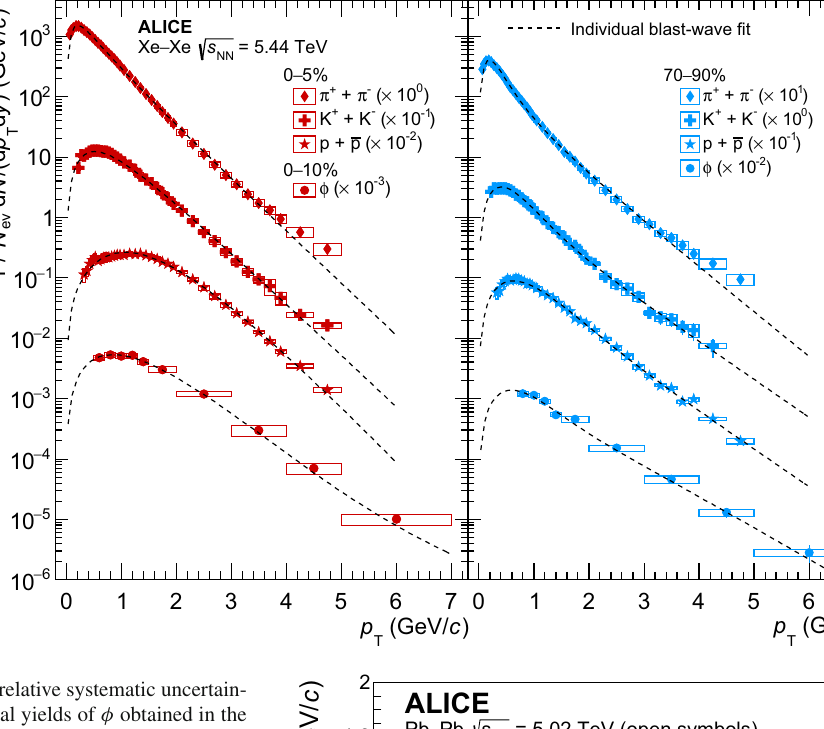
Table 3 Main sources and values of the relative systematic uncertain- ties (expressed in %) of the p T -differential yields of φ obtained in the analysis of Xe–Xe collisions. When two values are reported, they cor- respond to the lowest and highest p T bin respectively, considering the maximum contribution among the various centrality classes. If only one value is reported, the systematic uncertainty is not p T -dependent. The